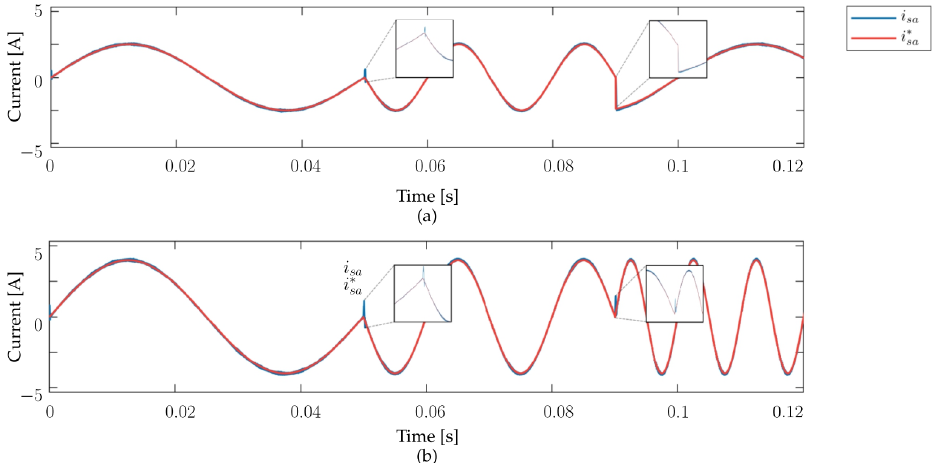
Figure 9. Current tracking results visualized as frequency changes. ( a ) Reference from 20 to 50 Hz and return to 20 Hz. ( b ) Reference from 20 to 50 and finally 100